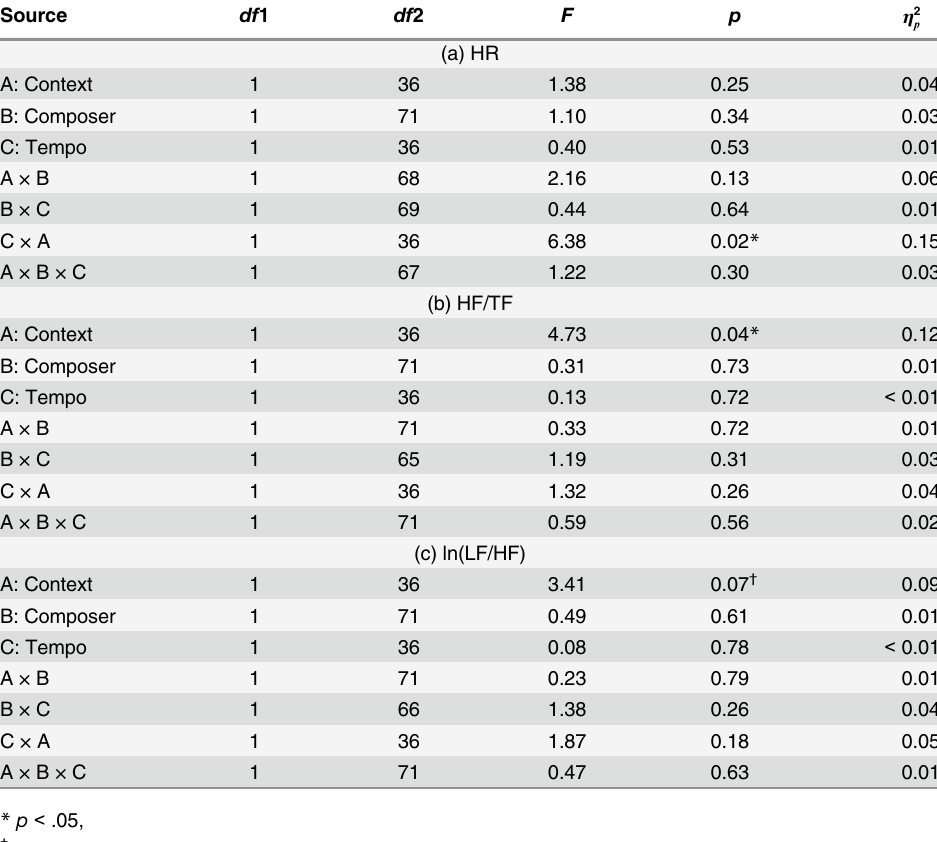
Table 3. The results of 2 (context) × 3 (composer)× 2 (tempo) within-subject analyses of variance for HR (a), the HF/TF ratio (b), and the natural logarithm of the LF/HF ratio (c). The degrees of freedom were adjusted by Greenhouse-Geisser